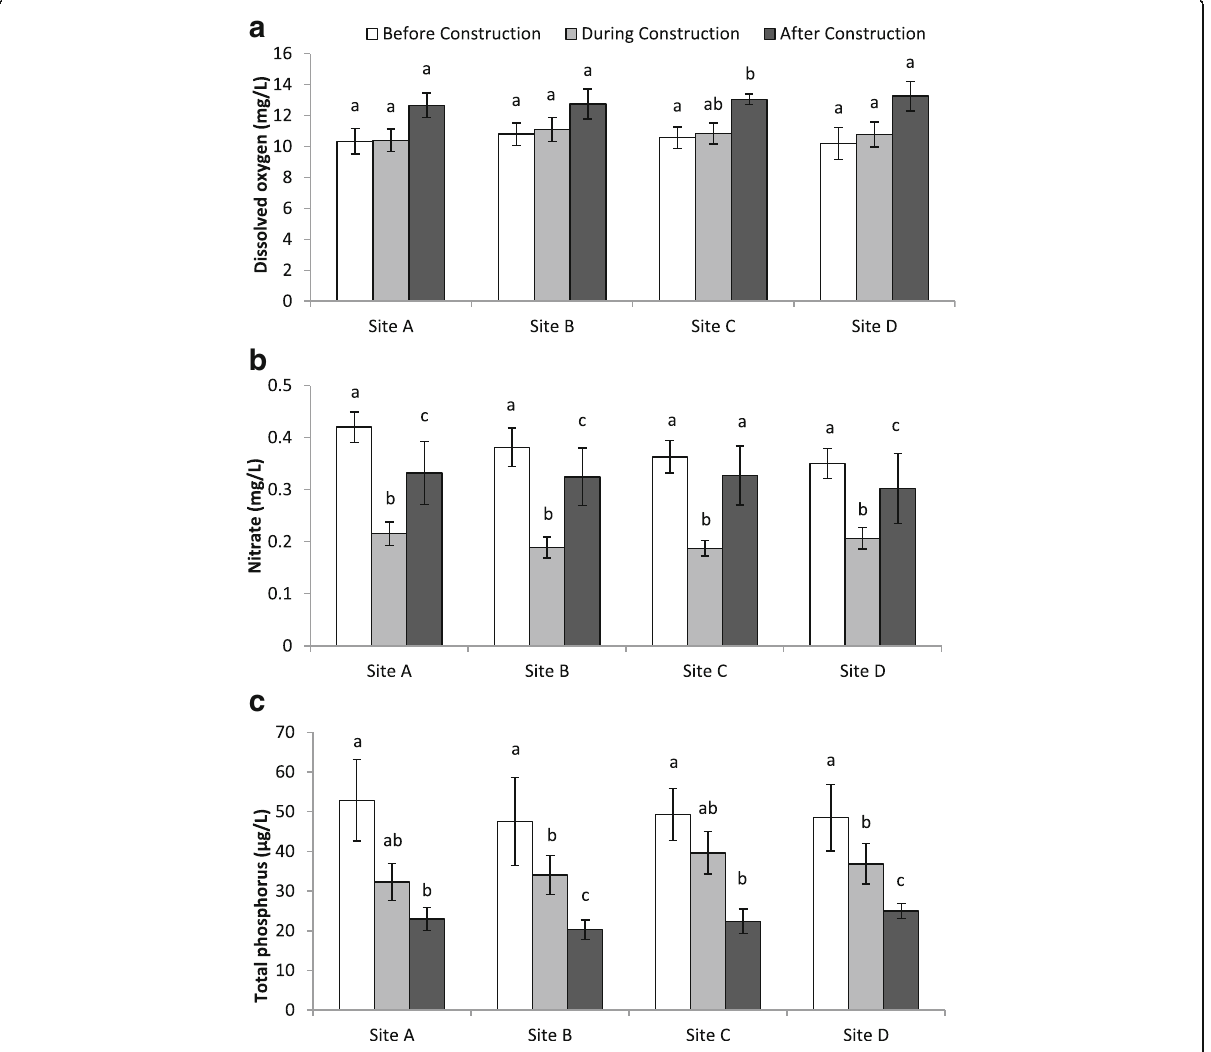
Fig. 3 Dissolved oxygen ( a ), nitrate concentration ( b ), and total phosphorus concentration ( c ) at the four sampling sites in the North Branch Park River. Bars indicate the mean ± 1 SE. The (a, b) markings above the columns indicate the groups identified with the Tukey test ( α =